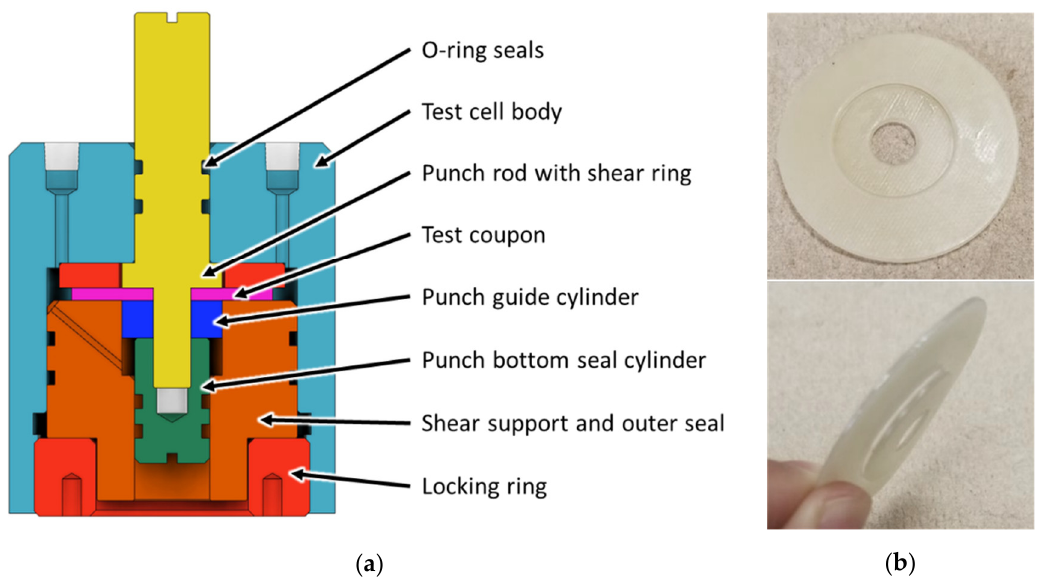
Figure 1. ( a ) Schematic of the in situ punch-shear-test cell, and ( b ) photographs of coupon sample after testing.